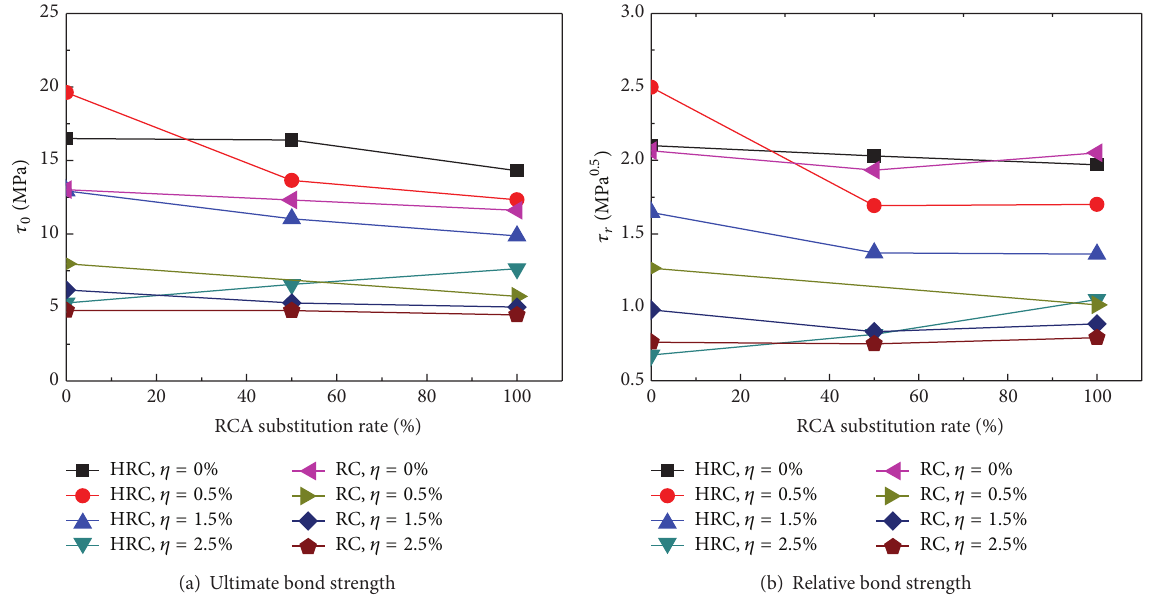
Figure 7: Bond strength versus RCA